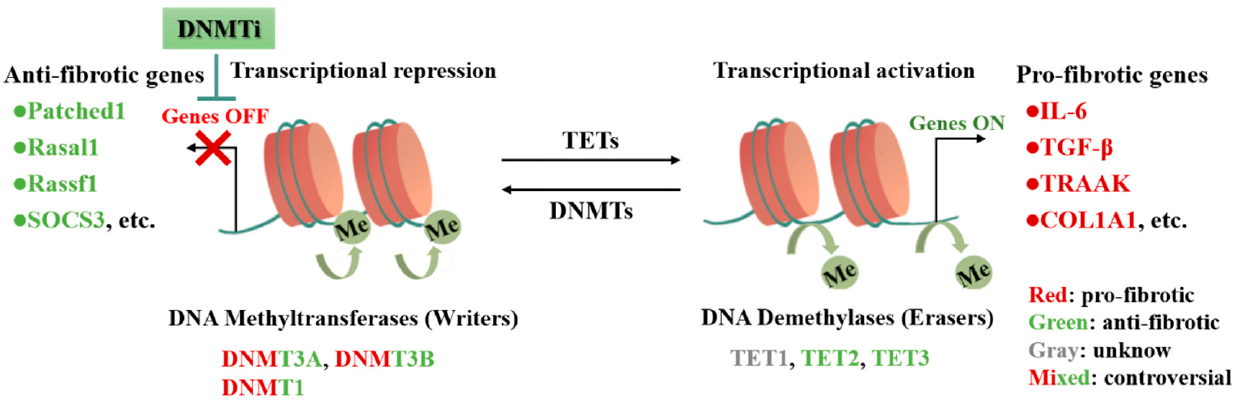
Figure 2. DNA methylation modifications regulate fibrosis-related genes involved in CFs activation and cardiac fibrosis. DNMTs and TETs cooperate to regulate DNA methylation levels, which determines the transcriptional activity of fibrotic genes as well as induces cardiac fibrosis. DNMTs as writers drive DNA methylation, repress transcription, and silence anti-fibrotic genes. Conversely, erasers’ TETs-mediated DNA demethylation activate transcription and involve in the activation of pro-fibrotic genes. As shown in the figure, different colors suggest that different genes and epigenetic-modifying enzymes play different roles in cardiac fibrosis. The application of DNMTi can target to alleviate DNA methylation-regulated cardiac fibrosis.